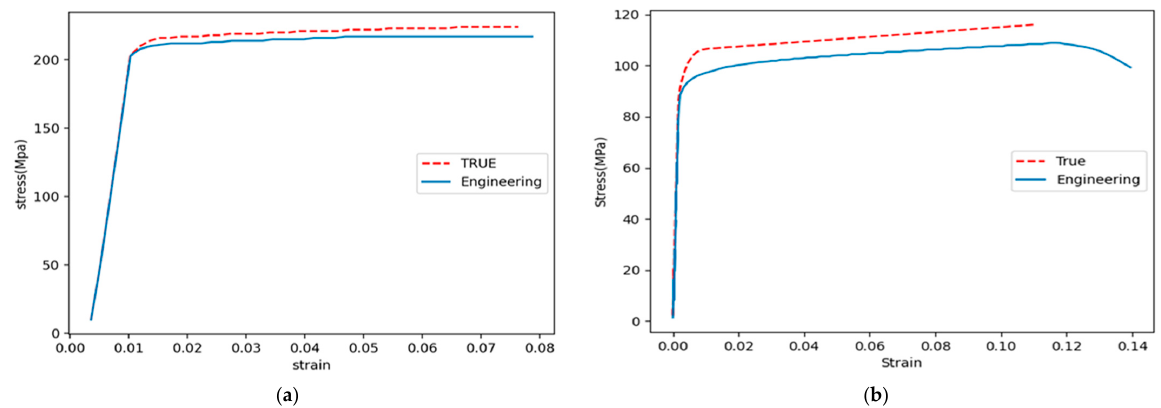
( a ) ( b ) Figure 6. True and engineering stress-strain curves obtained for AA7075-AA6061 ( a ) and AA7075-Cu ( b ) weld materials.